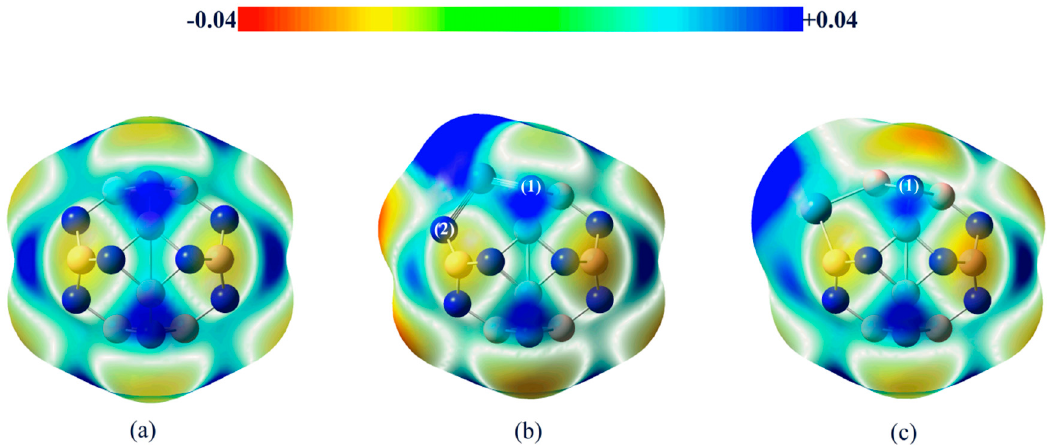
Figure 2. The molecular electrostatic potential of the B 12 N 12 ( a ), B 11 N 12 Ni ( b ) and B 12 N 11 Ni ( c ) clusters on the molecular van der Waals surface (electron density: 0.001, energies in a.u.).